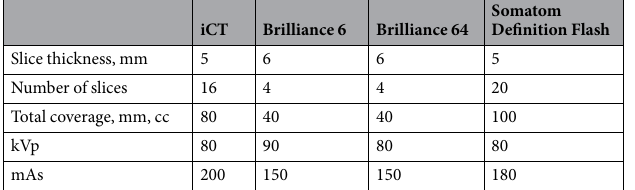
Table 1. CTP protocols of scanners included in the study. cc = craniocaudal. mAs = milliampere-seconds. kVp = kilovoltage